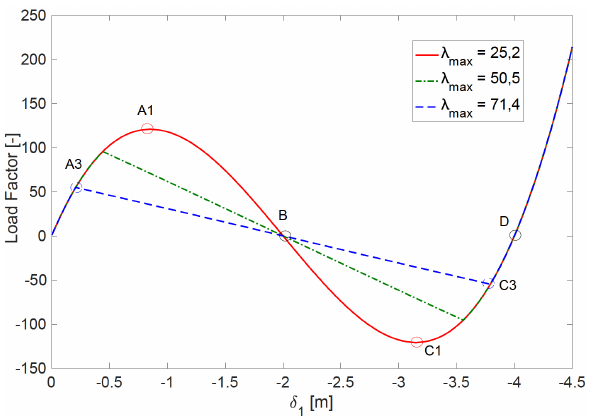
Figure 6: Eight-member structure displacements - λ max = 71.4